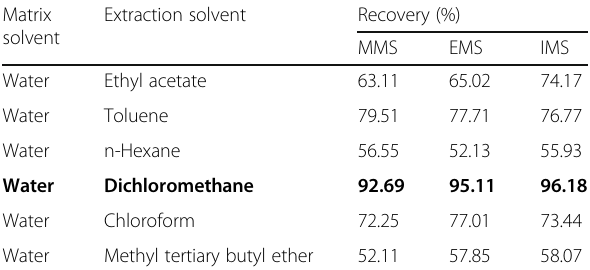
Table 3 Extraction efficiency of various extraction solvents Matrix Extraction solvent